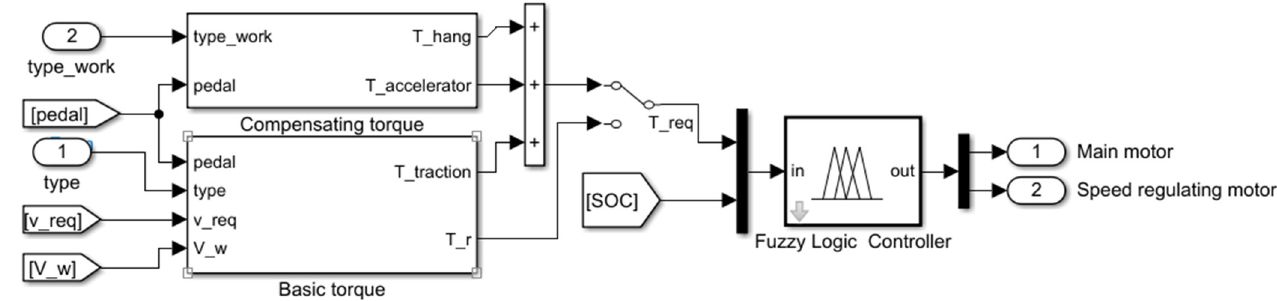
Figure 3. Demand torque calculation strategy model.